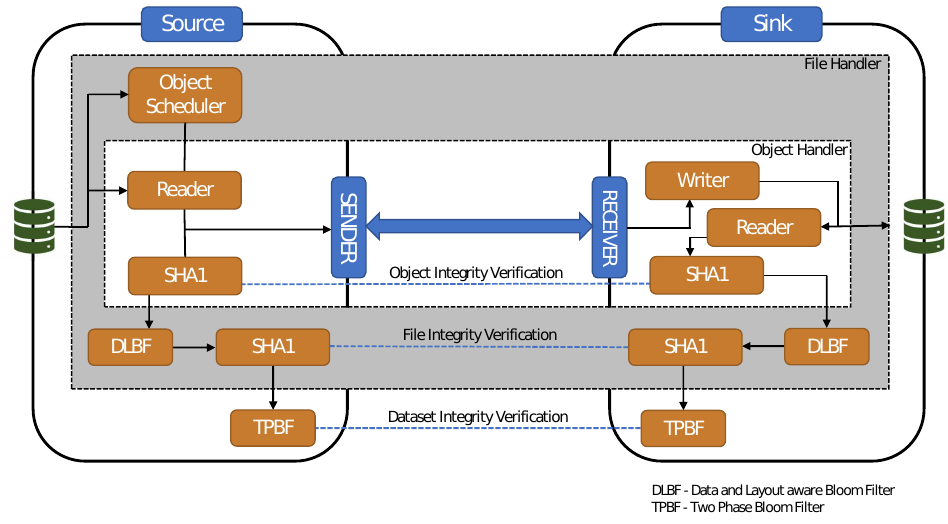
Figure 4. Two-phase Bloom-filter-based end-to-end data integrity framework